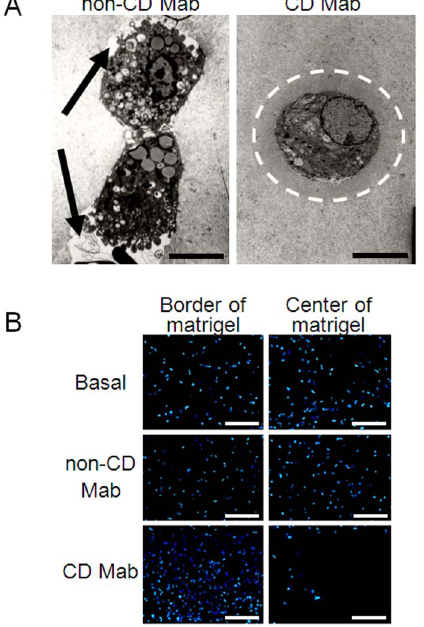
Figure 2. Cellular behavior is altered in the presence of celiac autoantibodies. (A) Transmission electron micrographs of mouse aorta ring experiments in the presence of monoclonal celiac patient- derived transglutaminase 2-targeted antibody (CD Mab) or its respective control (non-CD Mab). Arrows indicate the extracellular matrix (ECM)-free area in the leading edges of the cells treated with non-CD Mab and the white dotted line shows an area of densely organized ECM around a cell treated with CD Mab. Scale bar represents 6 m m. (B) Representative images taken from mouse matrigel implants treated with CD Mab or non-CD Mab. Nuclei are shown as blue (DAPI) from the border and center of the implants. Scale bar represents 300 m